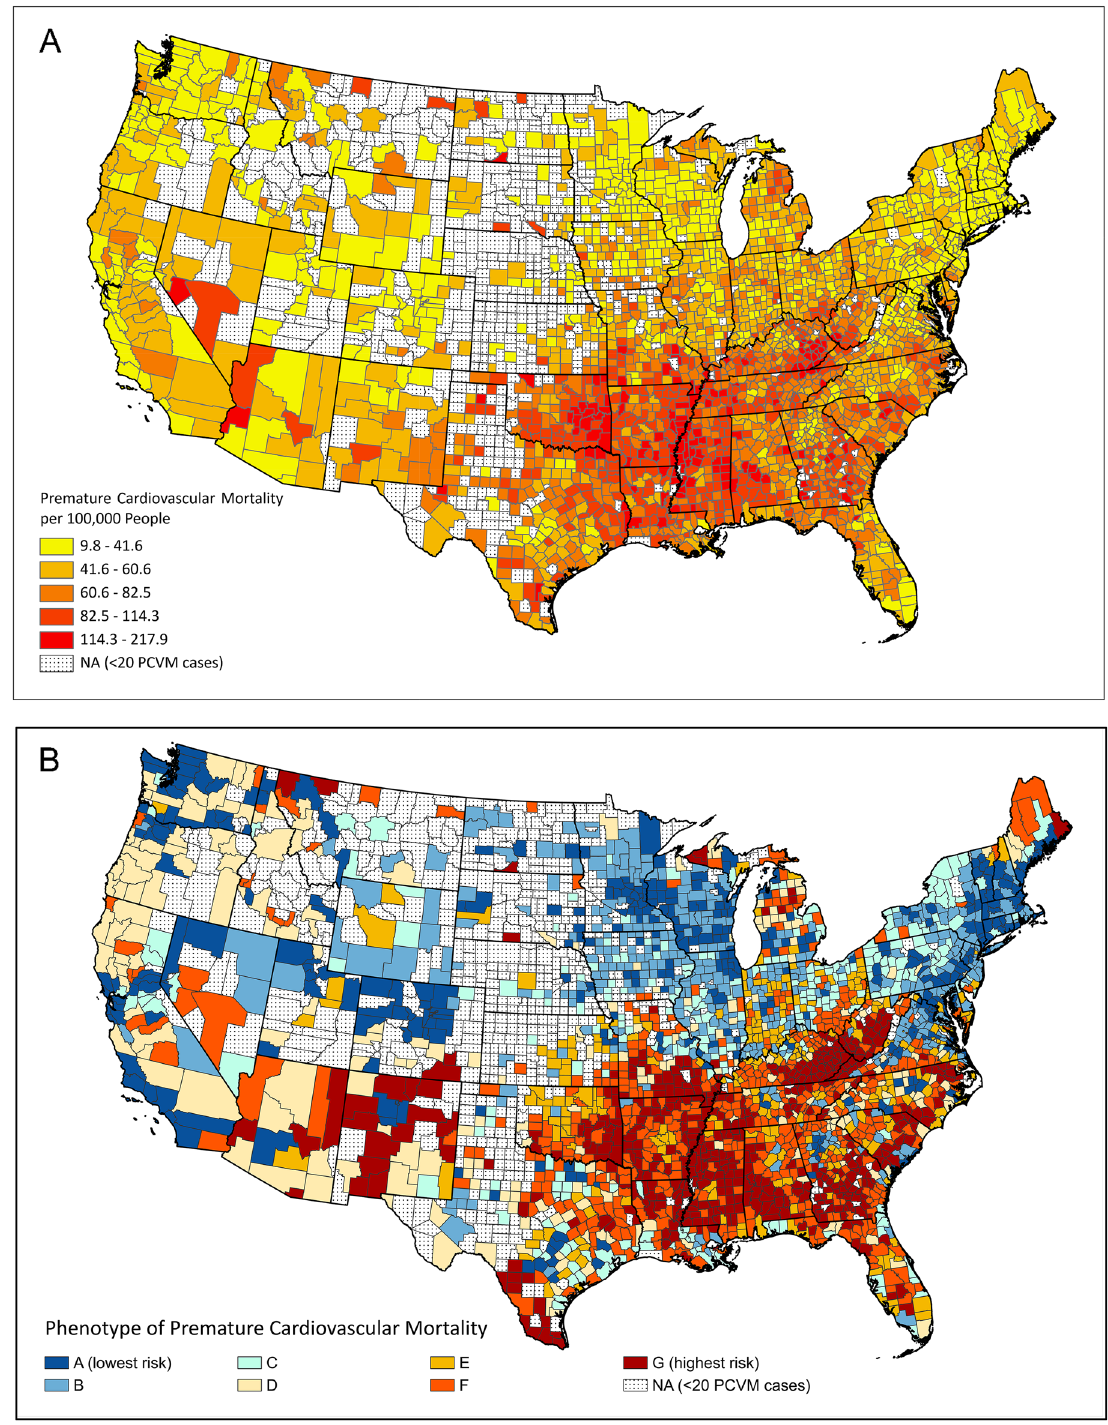
Figure 3. US County Maps of ( A ) age-adjusted premature cardiovascular mortality (per 100,000 people), and ( B ) county phenotypes of premature cardiovascular mortality. Note: maps were created by ArcGIS Pro v2.7.0 (https:// pro. arcgis. random forest plot. Other high-importance variables included broadband access, smoking, and receipt of SNAP benefits, which also appeared in the output of the CART analysis with a minimum number of 100 counties in terminal nodes (Supplementary Fig. S3). Excessive drinking, high school degree, and physical inactivity were ranked 8th to 10th in the variable importance plot.